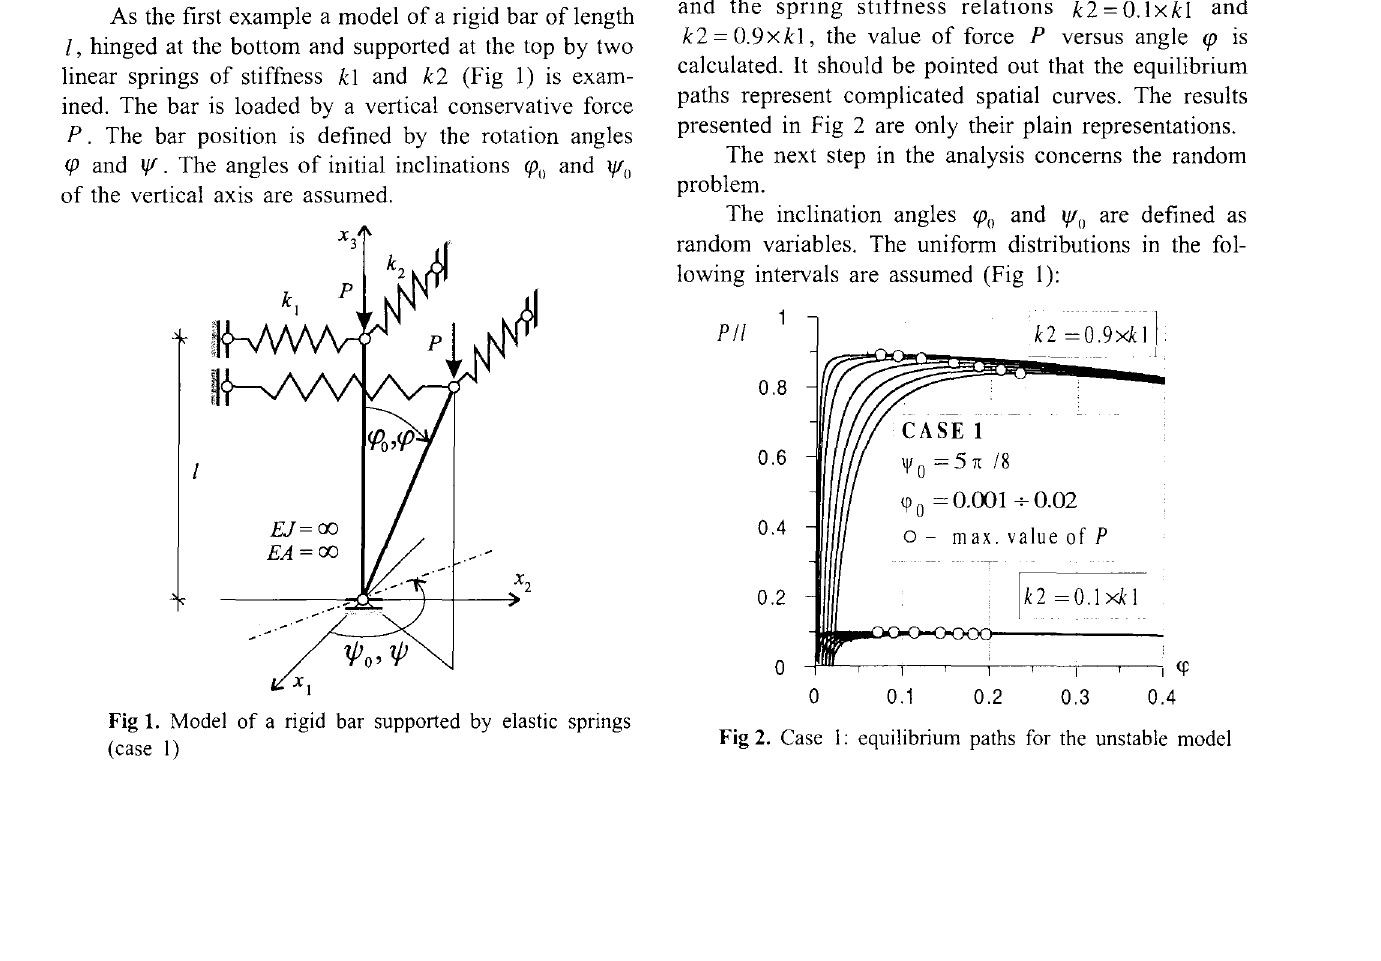
Fig 1. Model of a rigid bar supported by elastic springs (case I)